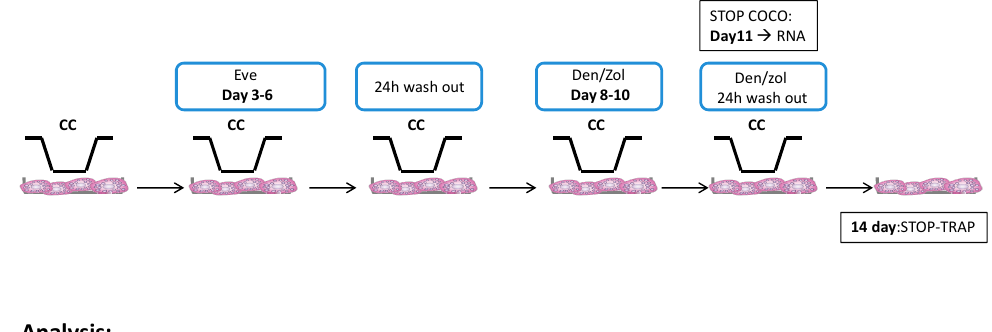
Figure 9. Drug treatment in direct COCO: schedule of Eve administered solely and in combination.